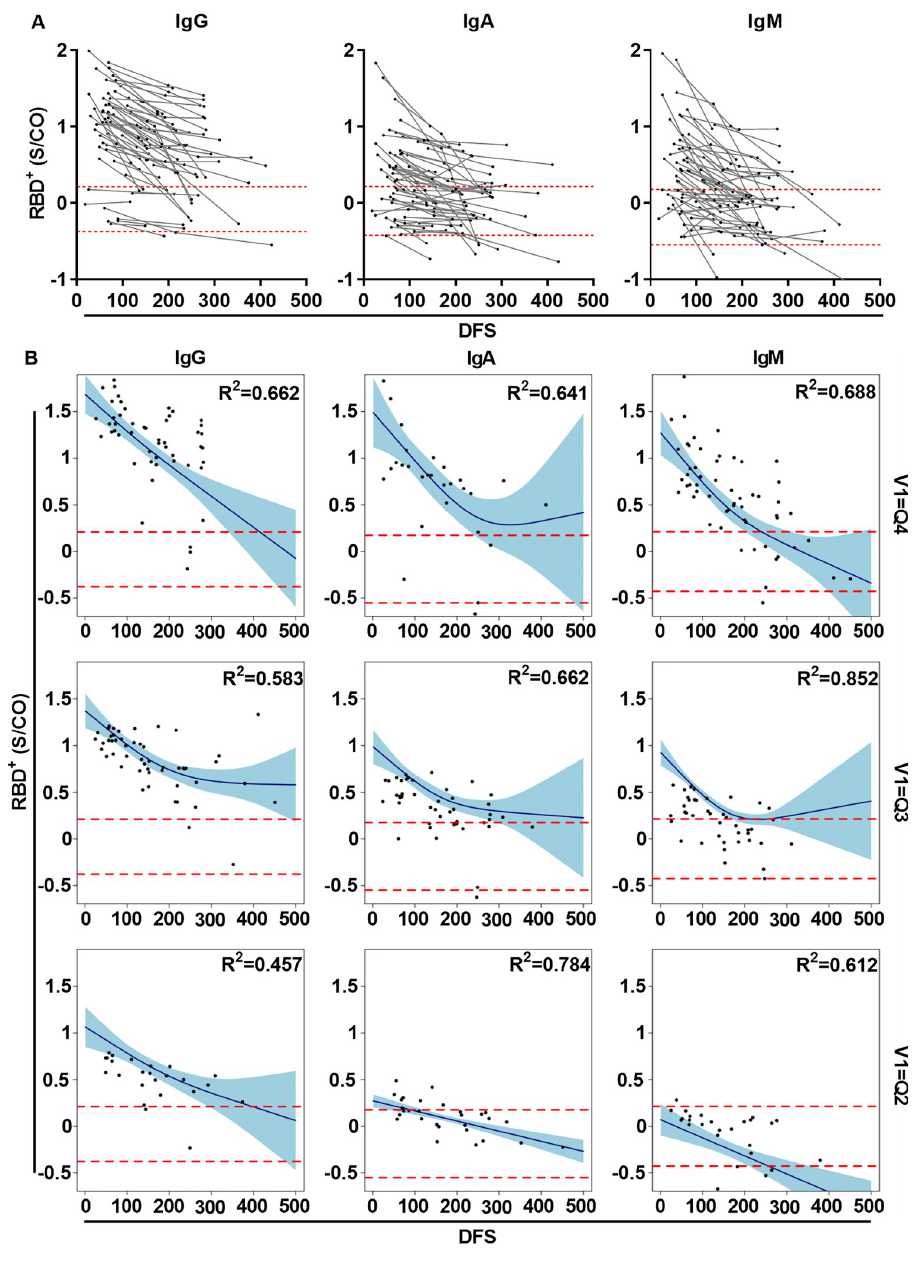
Fig 4. Longitudinal kinetics of RBD + antibodies in COVID-19 recovered follow-up patients. (A) RBD + IgG/A/M levels in COVID-19 recovered patients for whom we collected follow-up samples at visits 2–4. Y-axis in log 10 and x- axis show days following symptoms (DFS). Dashed red lines represent the range of the antibody levels as measured in negative control samples (n = 27). Follow up samples from the same patient are connected by gray lines. (B) GAMM analysis of RBD + antibody longitudinal kinetics stratified by quartiles. The antibody levels at V1 determined the assigned quartile, and follow-up samples from the same patients were used to determine the regression coefficients for each quartile. Four quartiles for each isotype were analyzed. The 95% CI is plotted in turquoise. For all plots, p values, R 2 , effective degrees of freedom (edf), and regression coefficients are shown in S2 Table. p values < 0.05 were considered